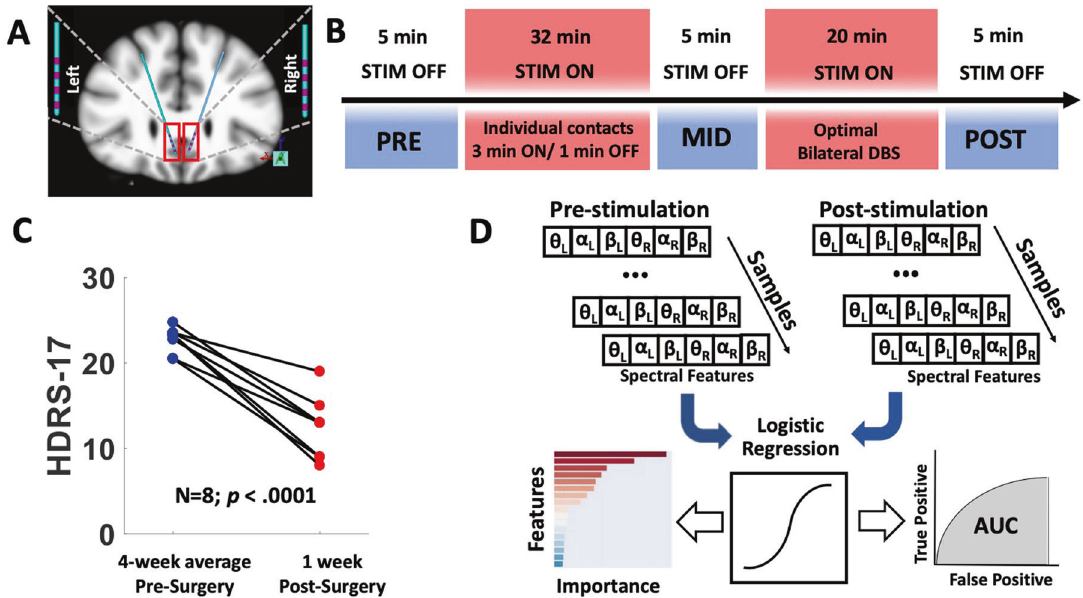
Fig. 1 Experimental design and analytic procedures. A Schematic of bilateral leads implanted in the subcallosal cingulate. B Timeline of intraoperative procedures. Blue boxes (PRE, MID, POST) indicate epochs of SCC local fi eld potentials (LFP) recording. C Decrease in symptom severity measured with Hamilton Depression Rating Scale (HDRS-17) following surgical implantation. D Machine learning (ML) analysis pipeline: classi fi cation models were developed from six LFP spectral features per subject to discriminate between PRE and POST epochs. ML outputs included area under the curve (AUC) and feature importance